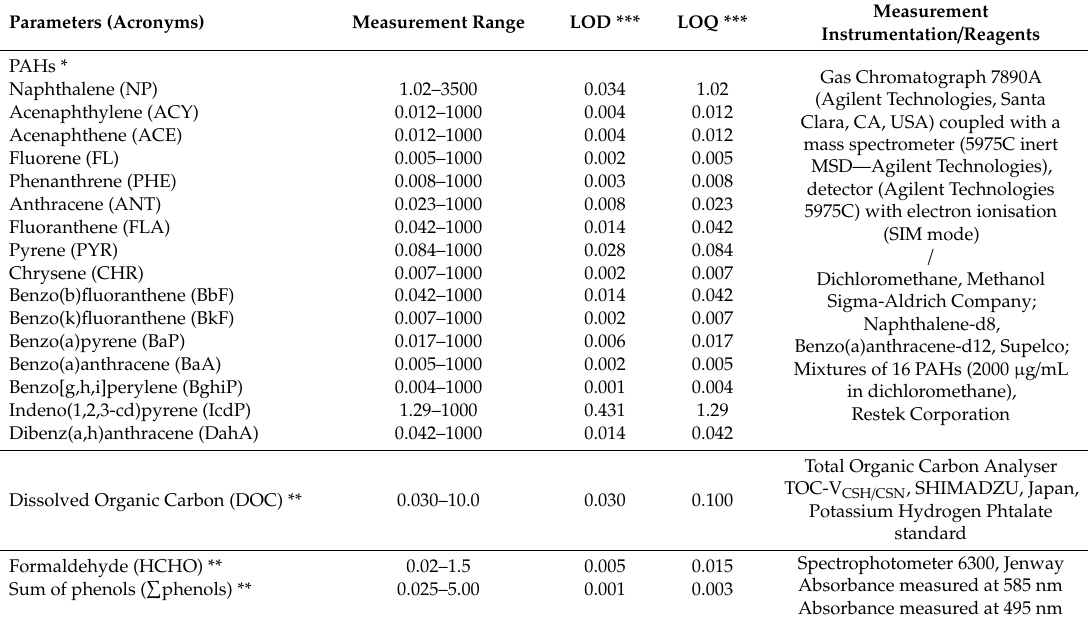
Table 1. Validation parameters and technical specifications used in analytical